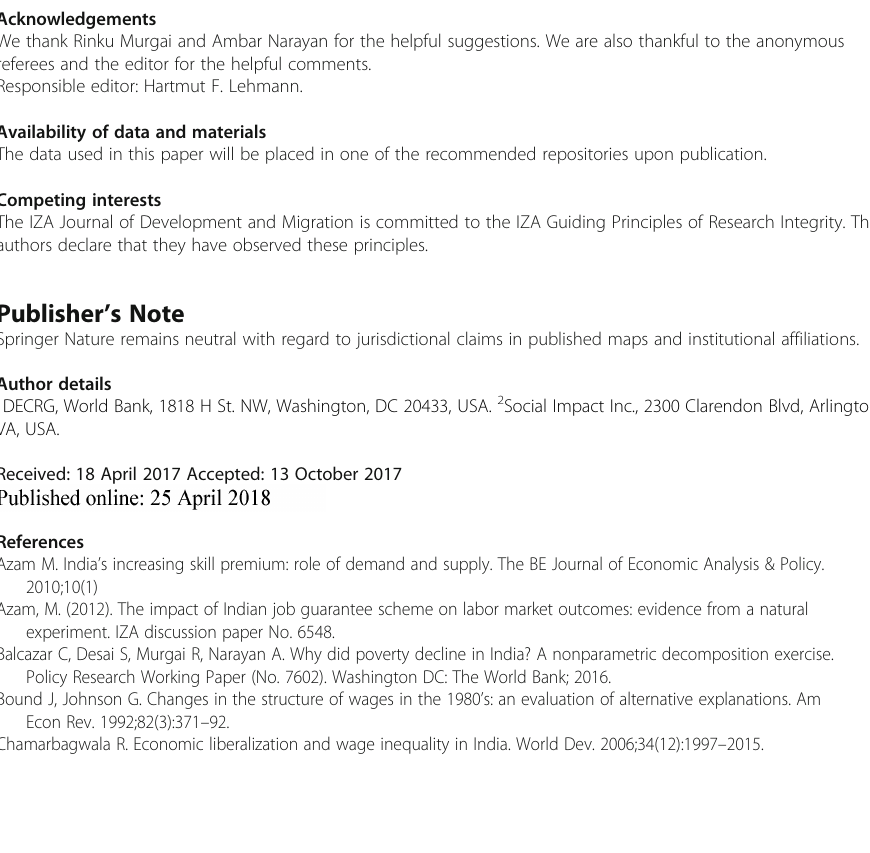
NSS: National Sample Survey; SDI: Supply-Demand-Institutions